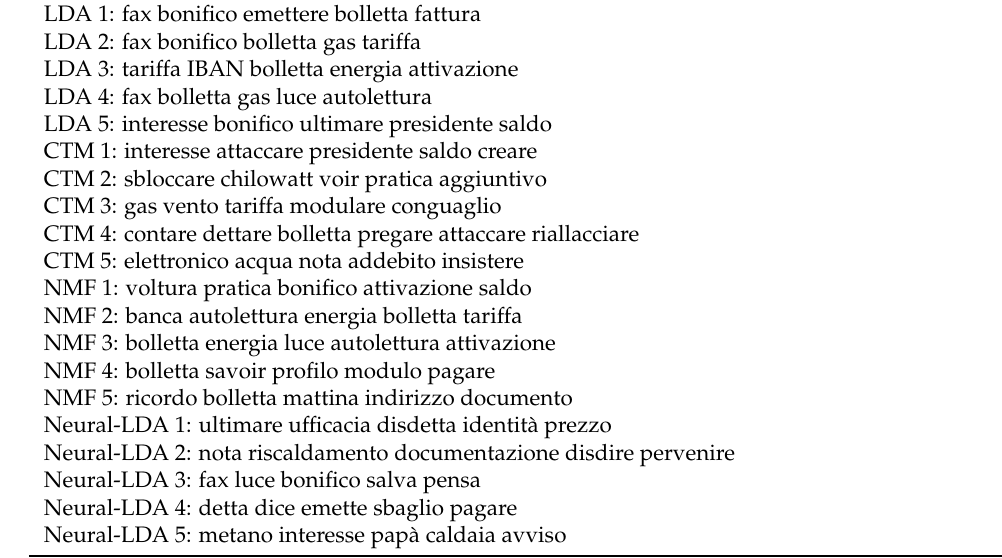
Table 1. Top five words for five topics, using k =